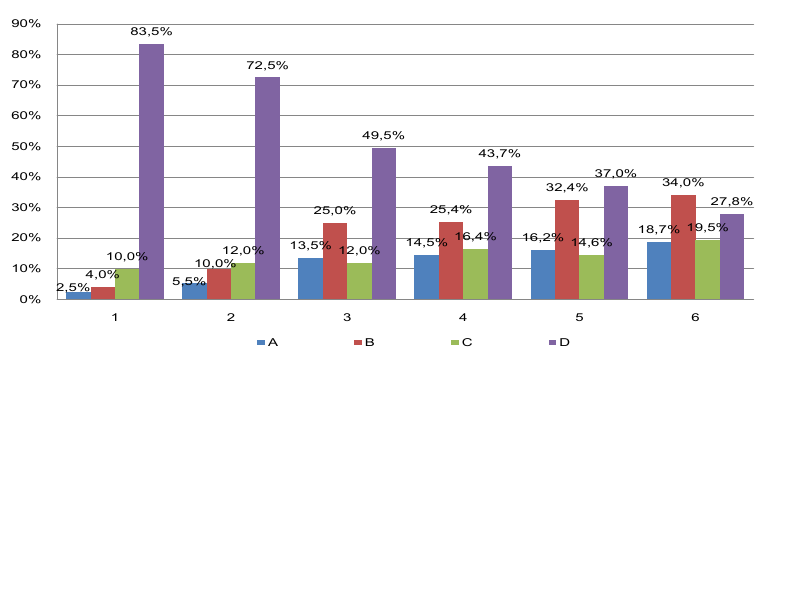
Fig. 1. Distribution of students by health groups in school and higher educational